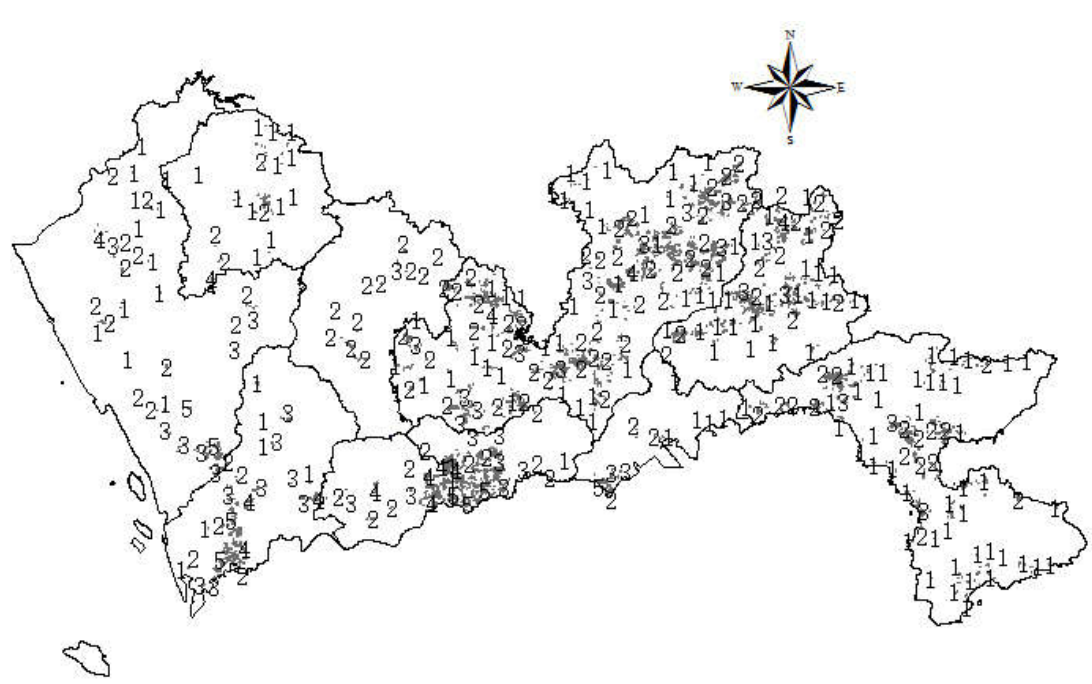
Figure 15. Map of distance to potential demolished buildings in the next 20 years.